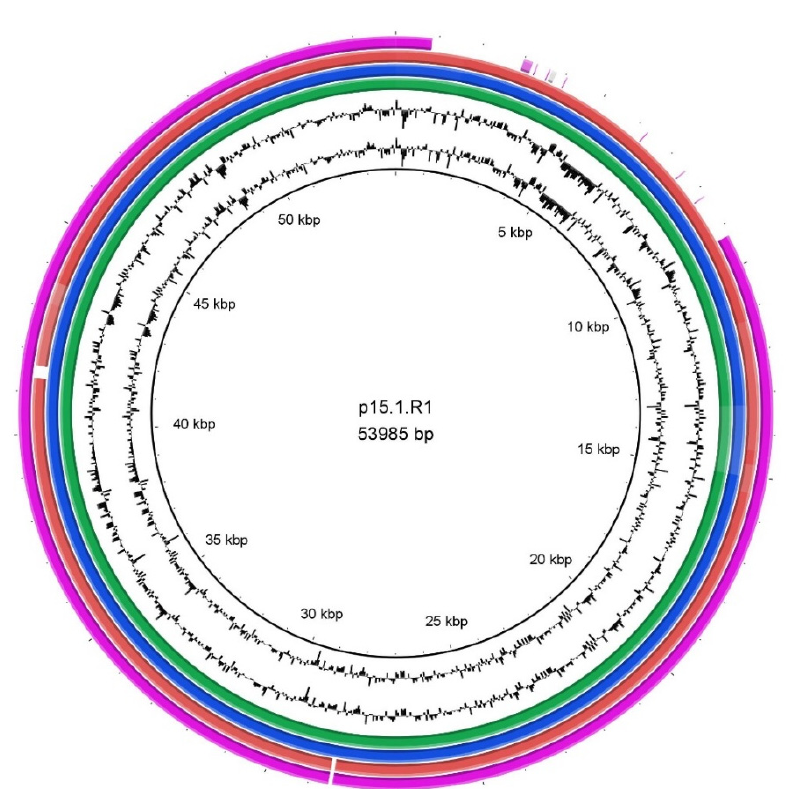
Figure 2. Comparison of a linear plasmid of C. acnes . The linear plasmid p15.1.R1 was used as a reference. The plasmid sequence was found in the strains ESL8 (green), HS29 (blue), 261 (red) and ZH8 (purple). Each strain belonged to a different SLST type (Table 1). A high synteny of the plasmid was detected in all four strains, which the exception of the plasmid in the ZH8 strain that had a deletion of approximately 10 kb.